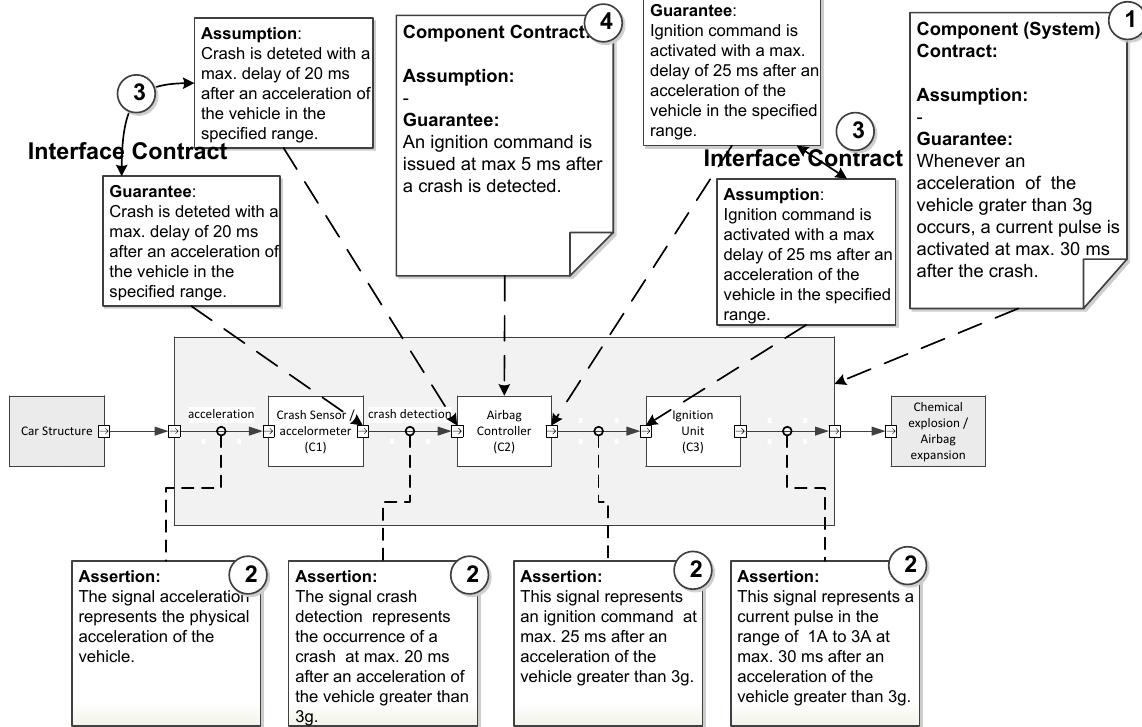
Figure 4. Use of contracts in the design of a Car Airbag